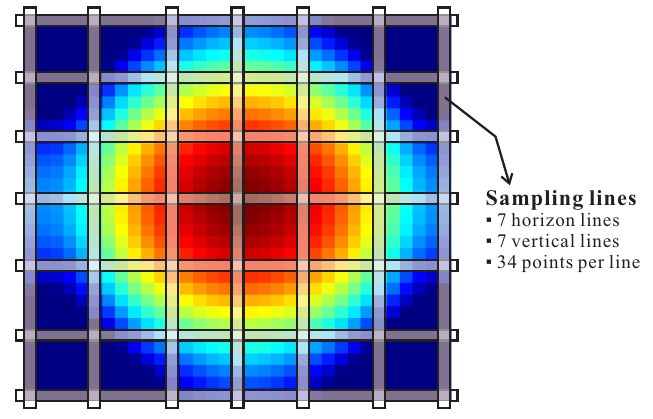
Figure 6. Position of sampling line in the near field.